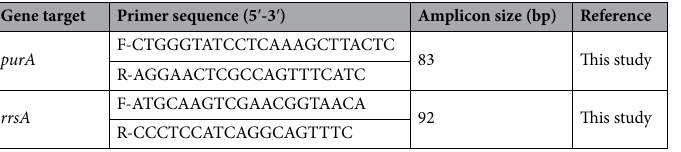
Table 1. Primer sequences used to identify and differentiate Shigella spp. by HRMA.